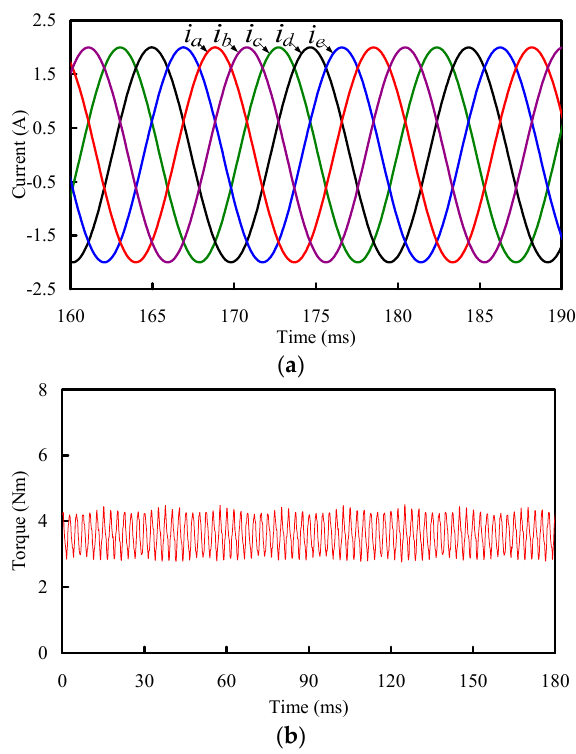
Figure 4. Performance under healthy condition: ( a ) Currents; ( b ) Output torque. Energies 2016 , 9 , 860